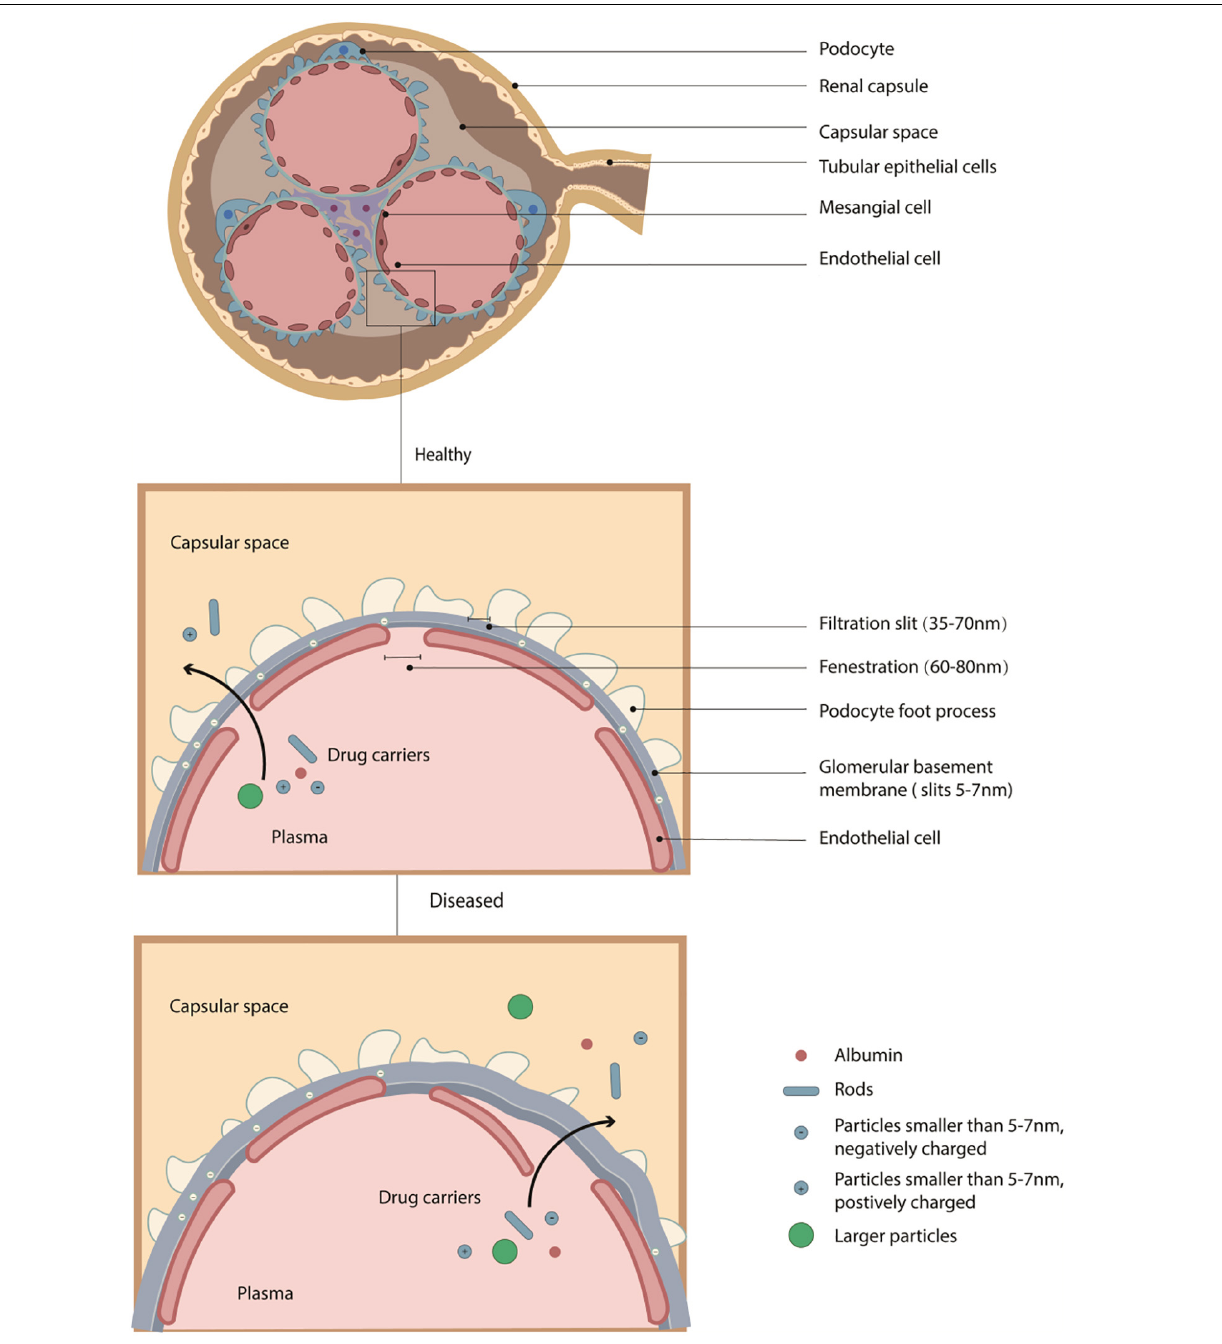
FIGURE 2 | The structure of glomerulus and the glomerular filtration membrane. The fenestration of endothelial cells sized about 100 nm. And the glomerular filtration barrier in a healthy kidney is negatively charged with slits at about 5–7 nm. And the fenestration between the foot process of podocyte is 35–70 nm. In healthy conditions, the filtration membrane can block negatively charged proteins and particles, and large molecules, but in the diseased situation, both the size or charge control of the barrier can be impaired, allowing particles with larger size passing